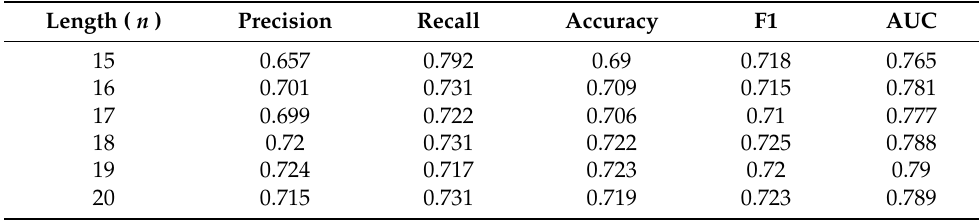
Table 6. Performance with different length of sub-sequences.